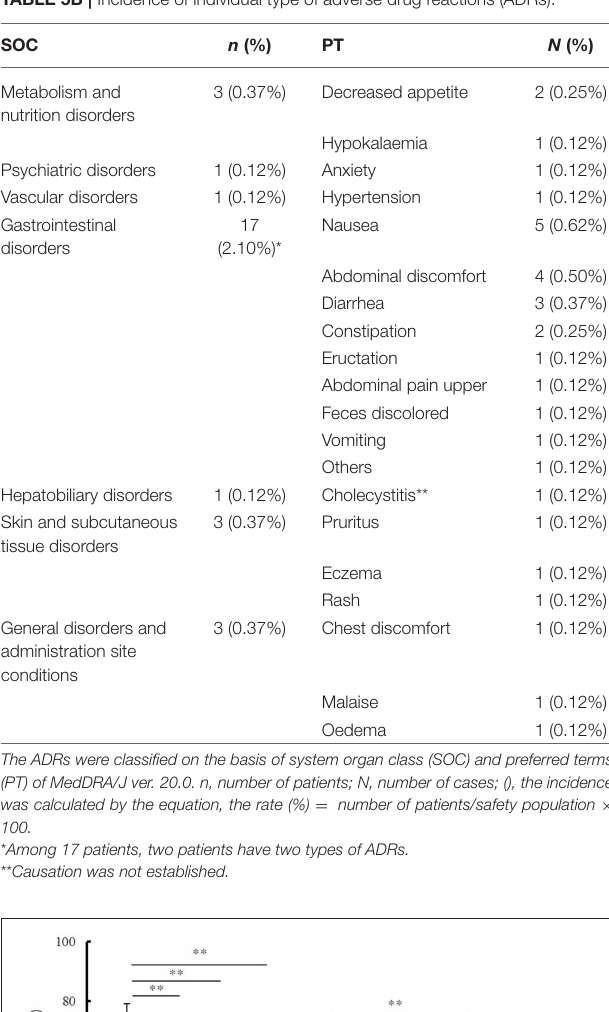
TABLE 5B | Incidence of individual type of adverse drug reactions (ADRs).